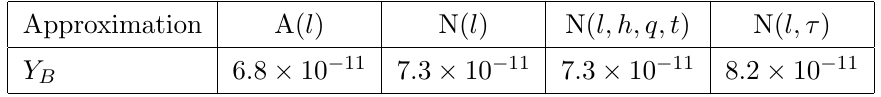
Table 1 . Baryon asymmetry Y B for a tau CPV source obtained using various approximations as detailed in the main text. We used the benchmark values for the bubble-wall pro(cid:12)le given in section 2.1 and (cid:3) (cid:28) = 1 TeV.